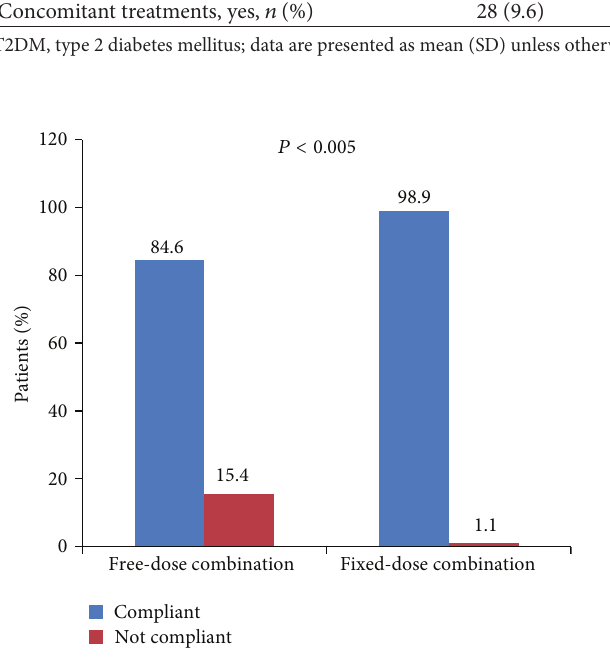
Figure1:Percentageofpatientscomplianttotreatment(logarithmic regression model, chi-square test).